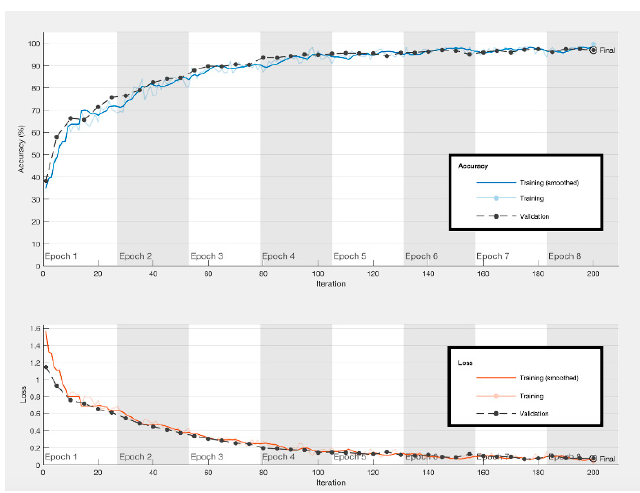
Figure 5. Training and validation learning processes.